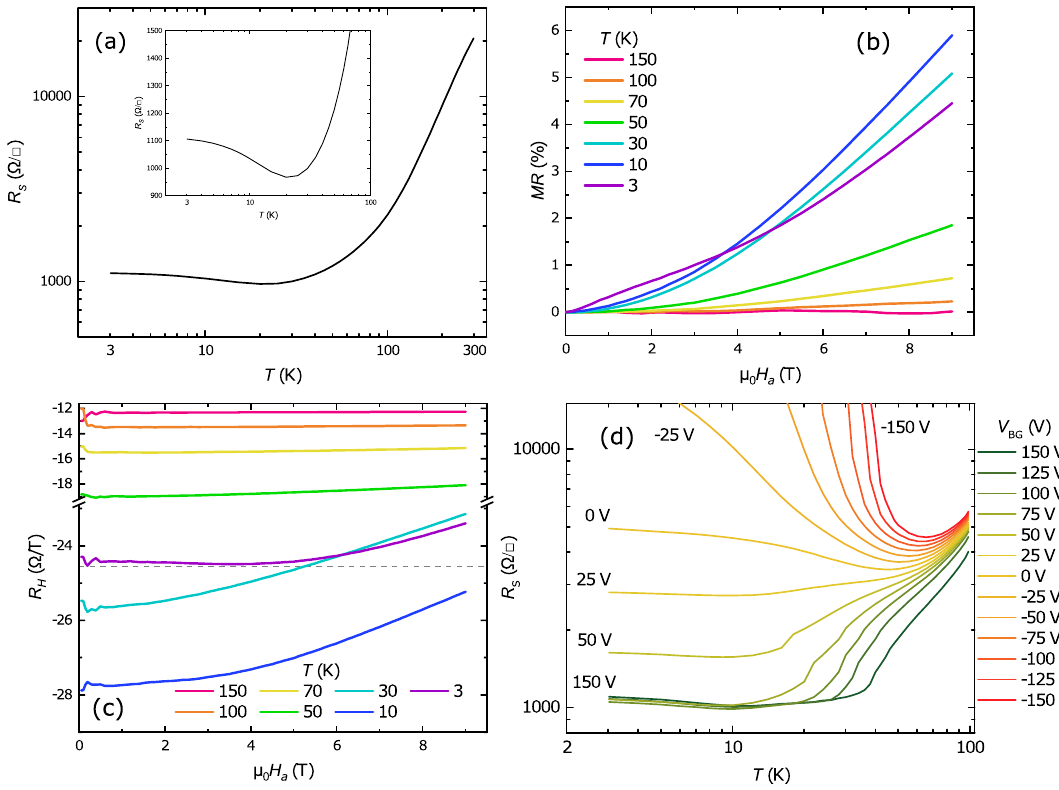
Figure 2. (a) Temperature dependence of the sheet resistance R S of the LGAO/GLTAO/STO sample during cool down. The same data with linear Sheet resistance scale in lower temperature region. (b) Field dependence of the magnetoresistance MR and (c) field dependence of the Hall coefficient R H . The horizontal grey dashed line serves to highlight the nonlinearity of the Hall coefficient at 3 K. Panels (a–c) show data before applying a gate voltage. (d) Sheet resistance R S versus temperature at different back gate voltages V BG in the range from 150 to −150 V as